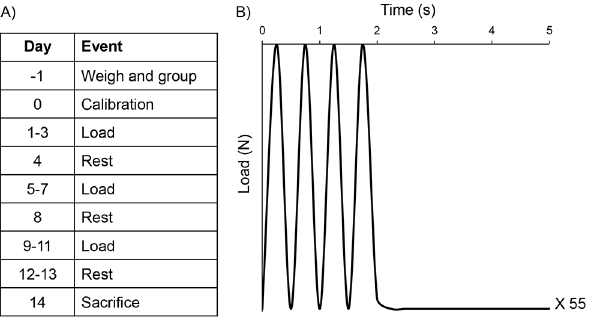
Fig 2. Timeline for tibial loading study and waveform profile. A) The right tibia of each mouse was loaded using the waveform to a set force (8.8N, 10.6N and 12.4N) to elicit a desired periosteal mid-diaphyseal tensile strain level (1700 με , 2050 με and 2400 με ) over a 14 day period. B) The loading profile consisted of four haversine waveforms followed by 3 seconds of rest repeated 55 times for a total of 220 cycles of loading per